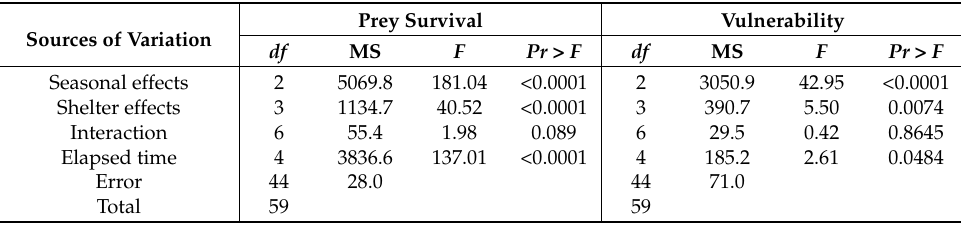
Table 4. ANOVA table for randomized complete block design (RCBD) in terms of prey survival and